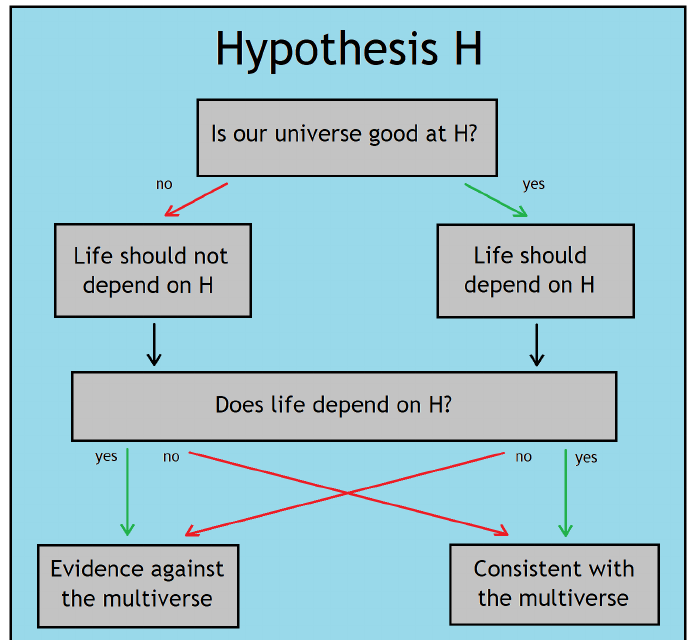
Figure 1. The underlying logic behind this task. We consider separate habitability hypotheses ‘H’, and determine whether our universe is good at H, in the sense that adopting this notion of habitability makes our presence in this universe probable (and equally importantly, that not adopting this notion makes our presence in this universe improbable). This yields a prediction for whether or not H is a good requirement for habitability that can then be tested against upcoming observations. There are dozens of proposed habitability criteria in the literature, and though not all of them will have a significant influence on our likelihood, many will. If we do live in a multiverse, we expect compatibility with all of these tests; if just one yields incompatible results, we will be able to rule out the multiverse hypothesis to a potentially very high degree of